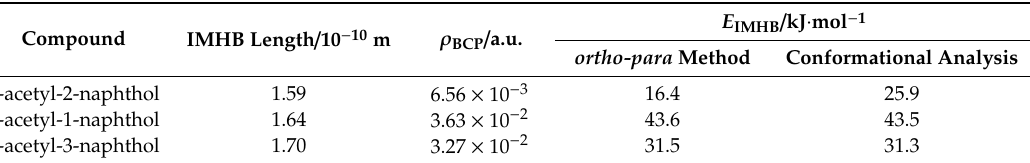
Table 3. Energy and respective length of the intramolecular hydrogen bond (IMHB) present in the